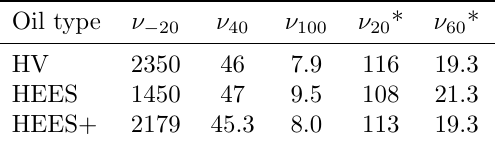
Table 2: Viscosity of the tested oils. ν x [cSt] ( ν at x ◦ C). Values at -20, 40 and 100 ◦ C are from data sheets. 20 ◦ C and 60 ◦ C are calculated using the Uddebuhle-Walther equation and the two nearest data sheet values.(Shell, 2013),(Sta- toil, 2013a),(Statoil,